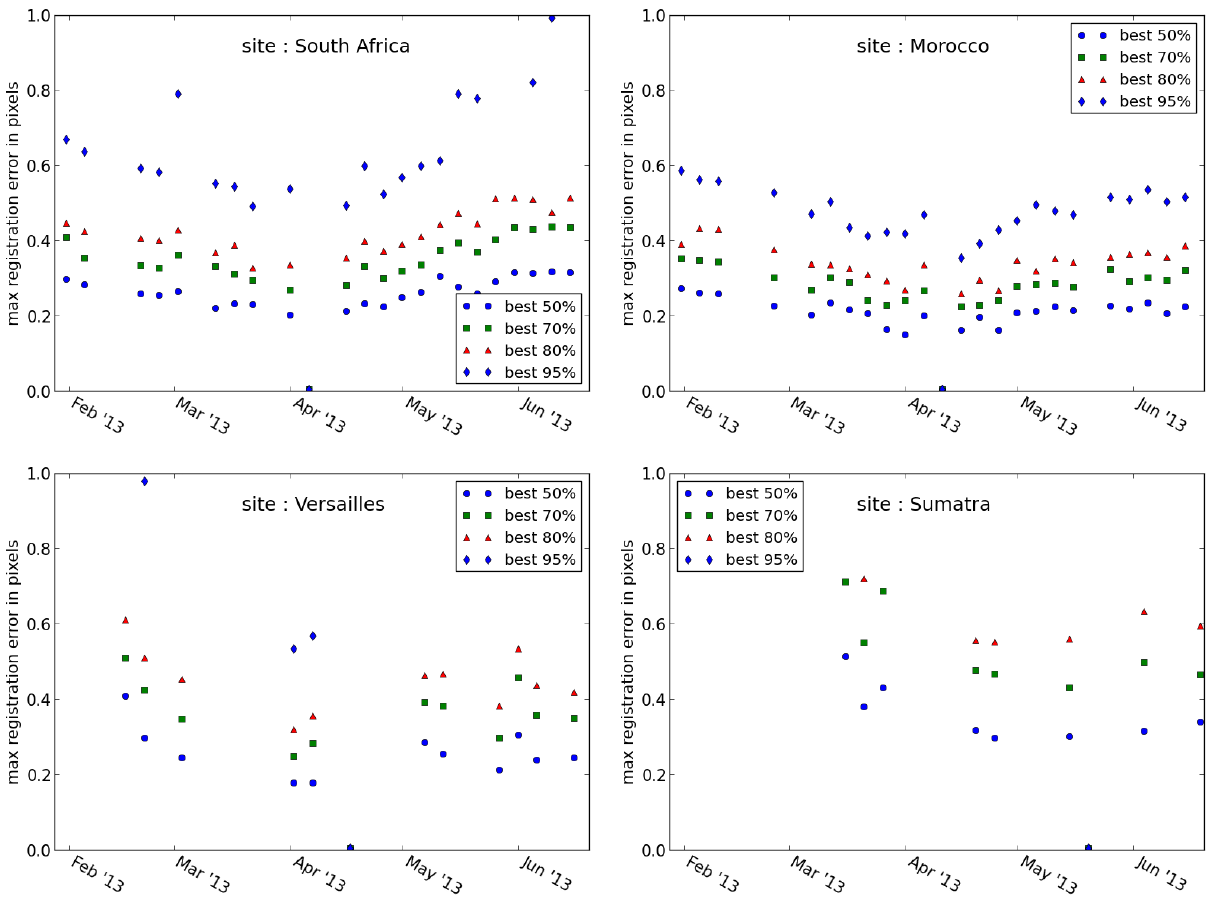
Figure 4. Multi-temporal registration performances obtained for the South Africa, Morocco, Versailles and Sumatra sites, using as a reference the image of the date for which performances are shown equal to zero. The maximum registration error is provided for the best 50%, 70%, 80% and 95% of measurements. In some cases and for the high percentages, the maximum error might exceed one pixel and is not visible in the plot. This happens only for images with a very large cloud cover, but it is always the case for